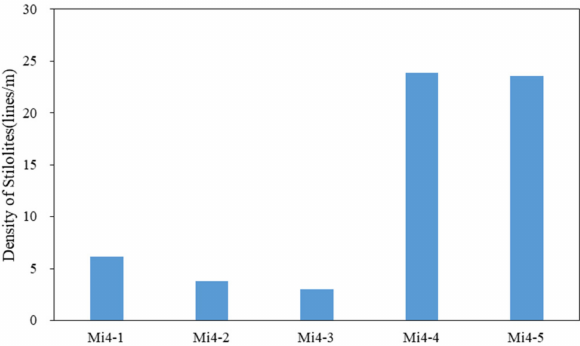
Figure 8. The density of stylolites in the Mi4 member under the thin sections.